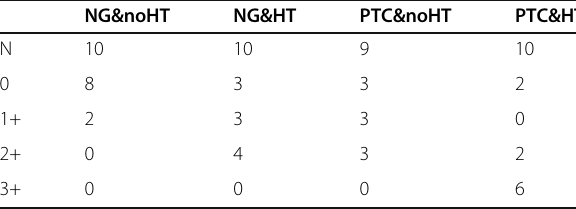
Table 3 PD-L1 immunohistochemical staining